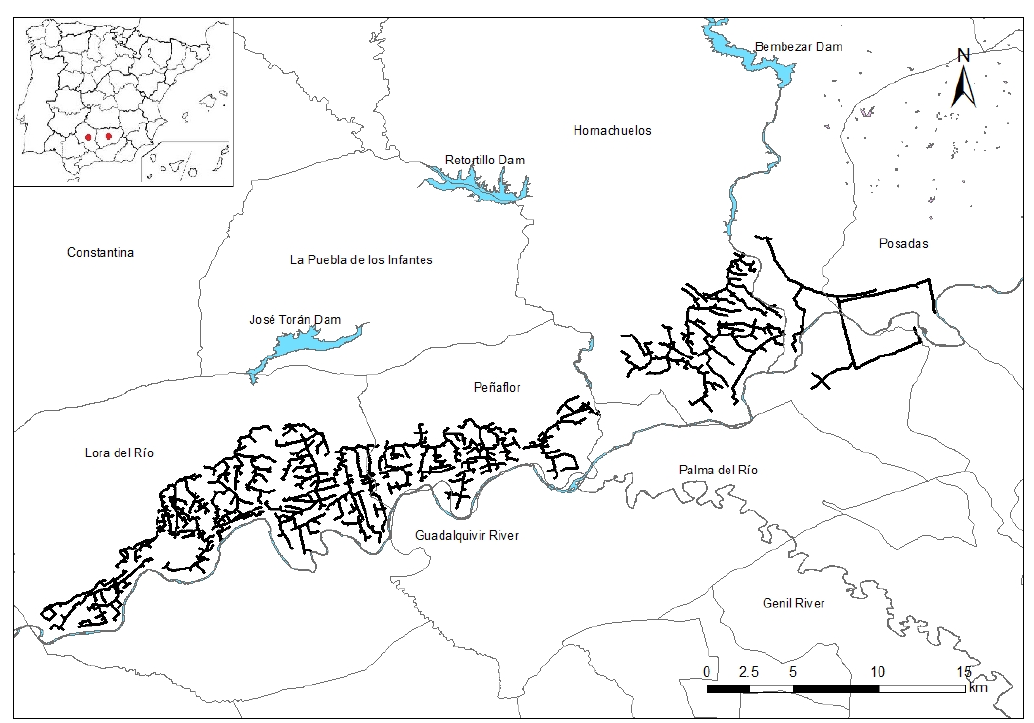
Figure 1. Location of BMI and BMD irrigation